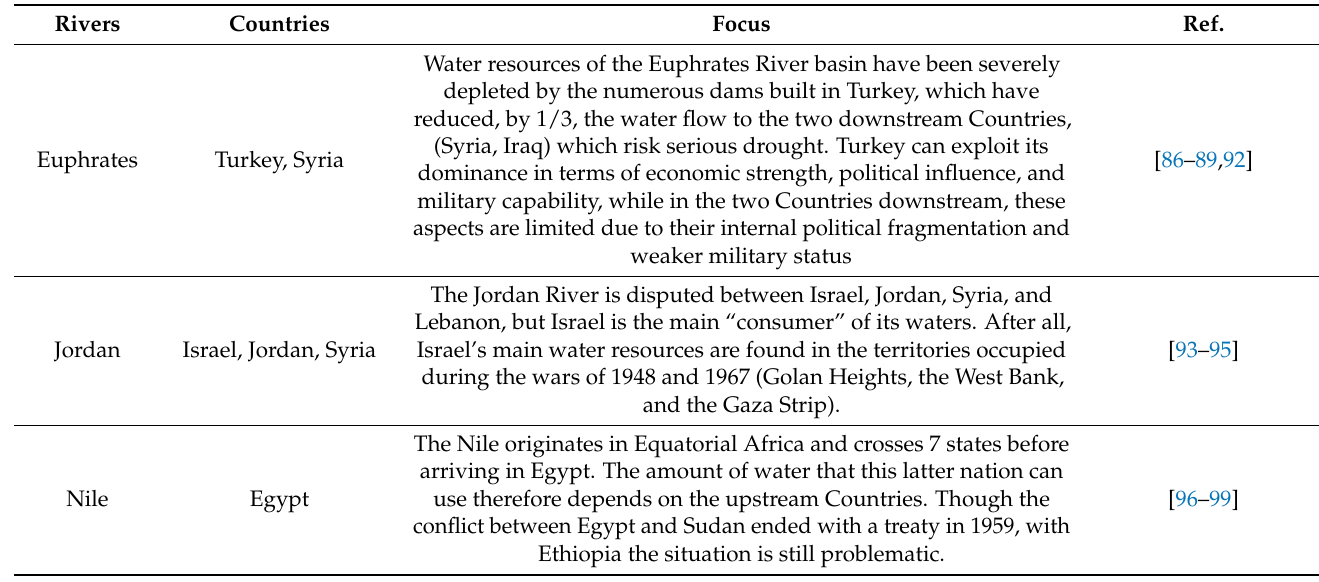
Table 3. Main disputes for river basin management in the Mediterranean